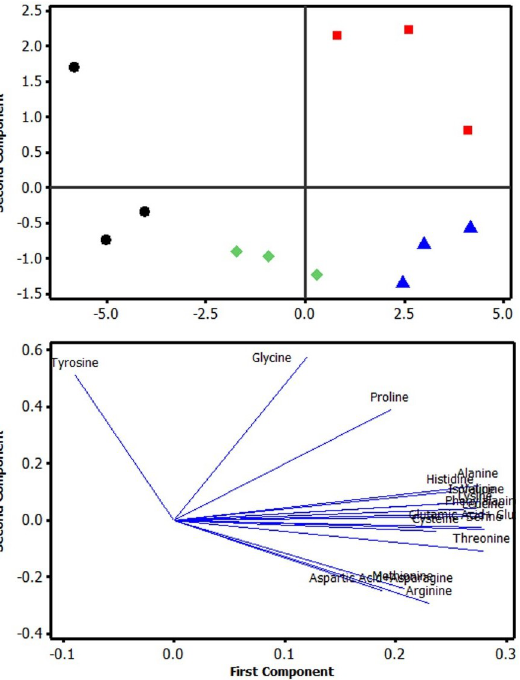
Fig 1. Principal component analysis of the muscle amino acid composition. Score biplot (A) and loading plot (B) of the first and second principal components for amino acid between amino acid and dietary treatment. The first and second principal component explains 83.50% of the sample variation. Diets: 40% ( ● ), 45% ( ■ ), 50% ( ♦ ), 55% ( ▲ ) dietary protein level.